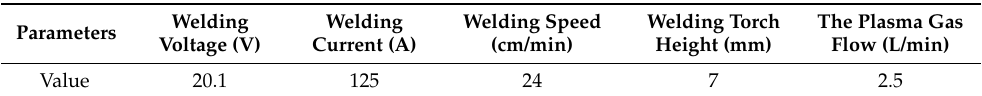
Table 2. The parameters of the plasma welding process. Welding Parameters